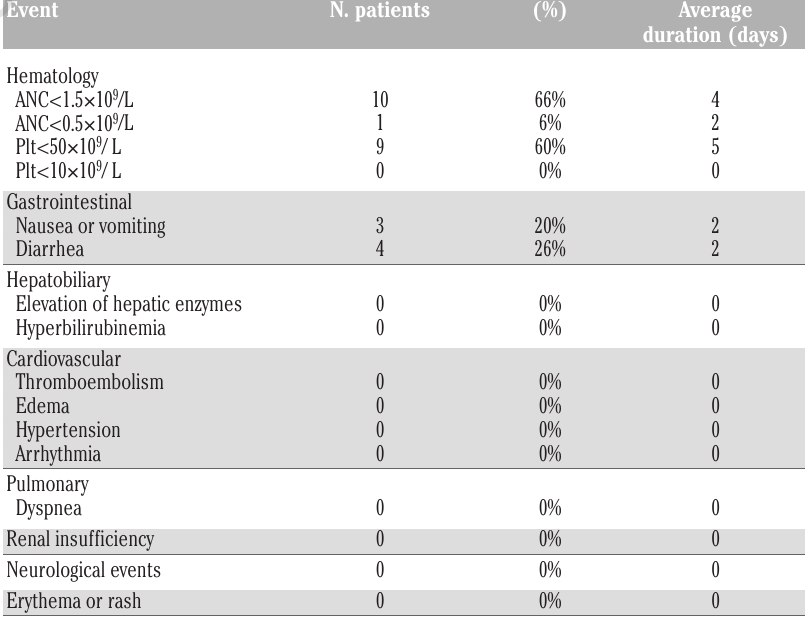
Table 4. Side effects in the intervention